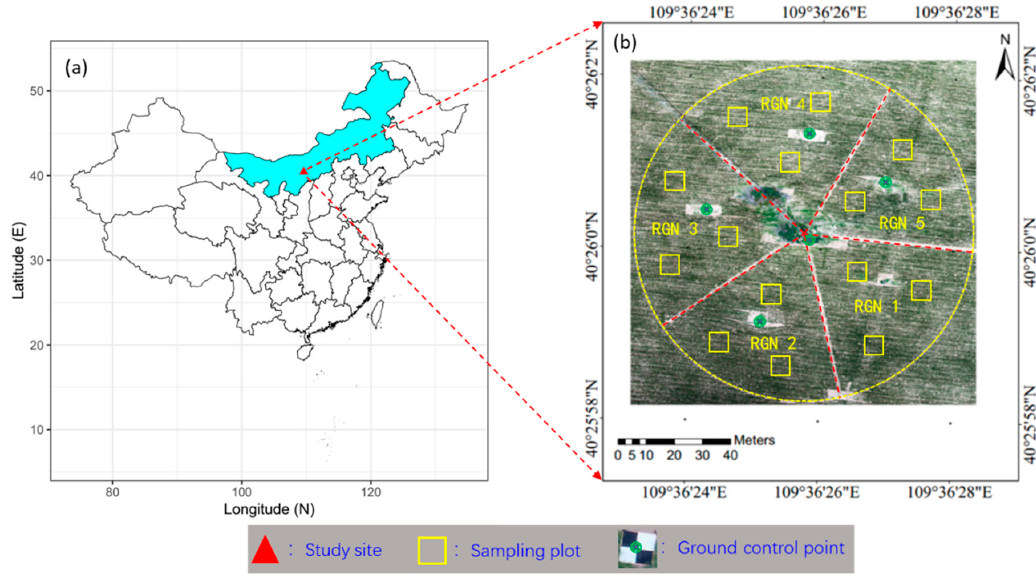
Figure 1. Location and region division of the research field: ( a ) location of the research field in China; ( b ) aerial view of the research field indicating regions division, the location of sampling plots, and ground control points (green round). RGN is the abbreviation of region. The aerial image was taken on DOY 185.